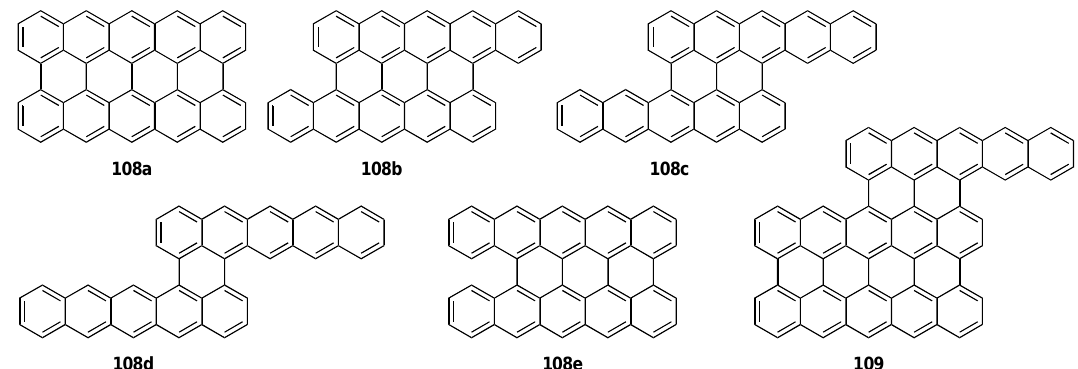
Figure 11. Proposed structures for 108a–e and 109